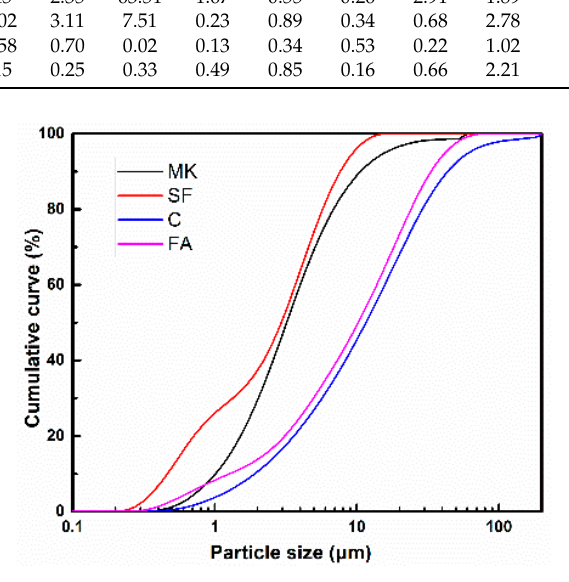
Figure 1. Particle size distribution curve of raw materials.